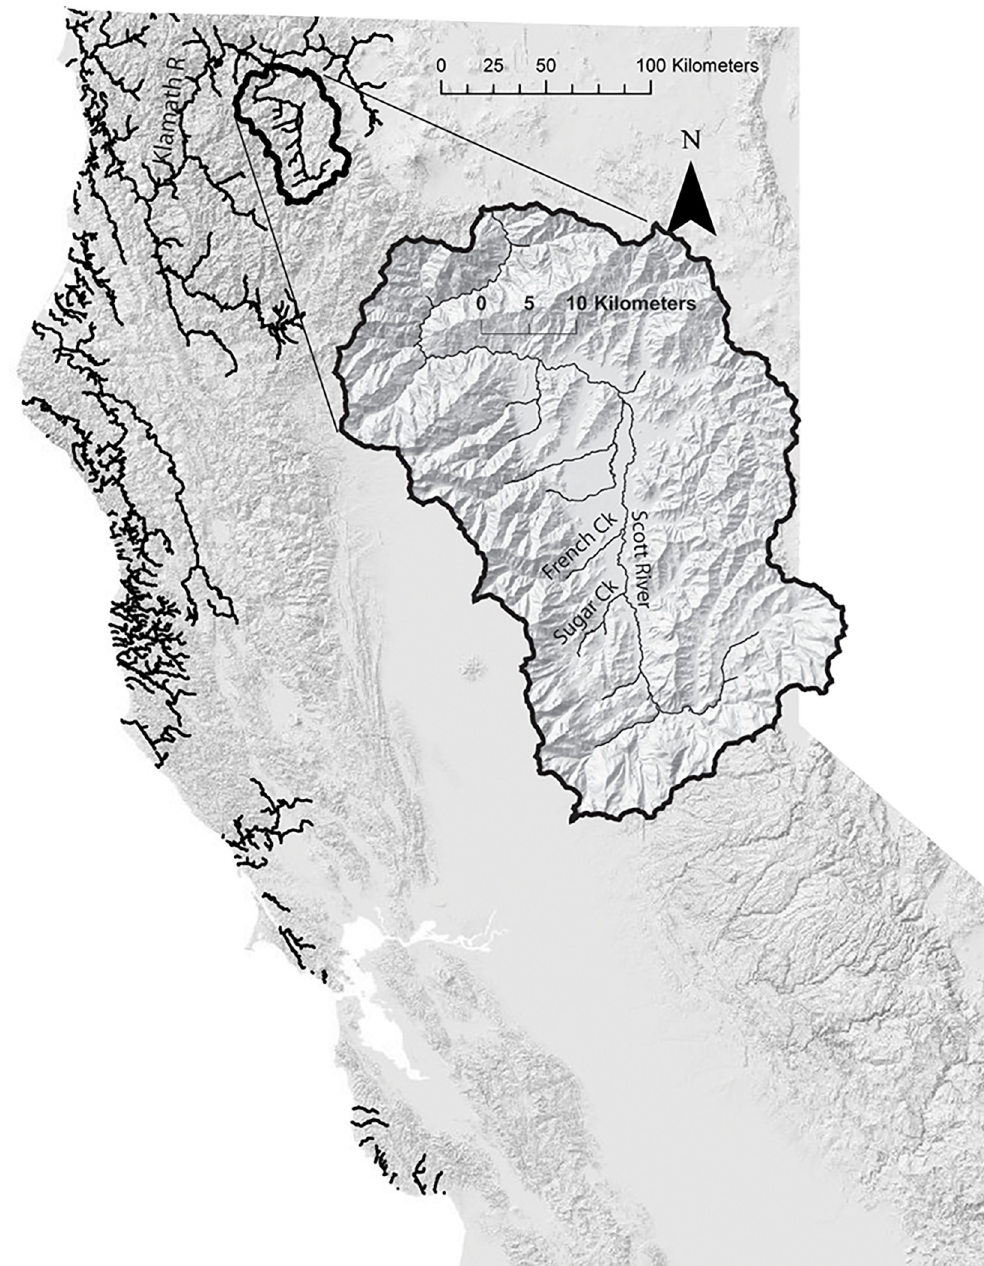
Fig 1. Site map of the Scott River, a tributary to the Klamath River, California, USA. Black lines indicate the current extent of coho salmon in California. Inset shows the topography of the Scott River watershed and the location of Sugar Creek in the upper watershed. California is located on the western coast of the United States of America, north of Mexico and south of the state of Oregon.